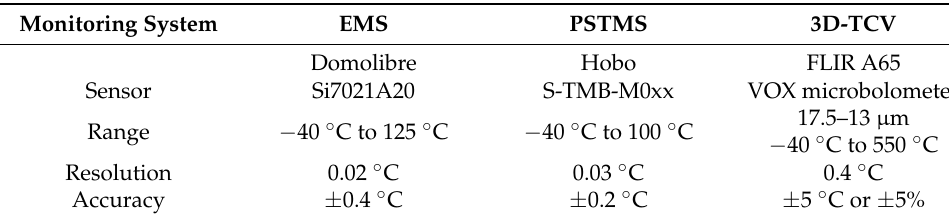
Table 1. Range, resolution, and accuracy of the sensors